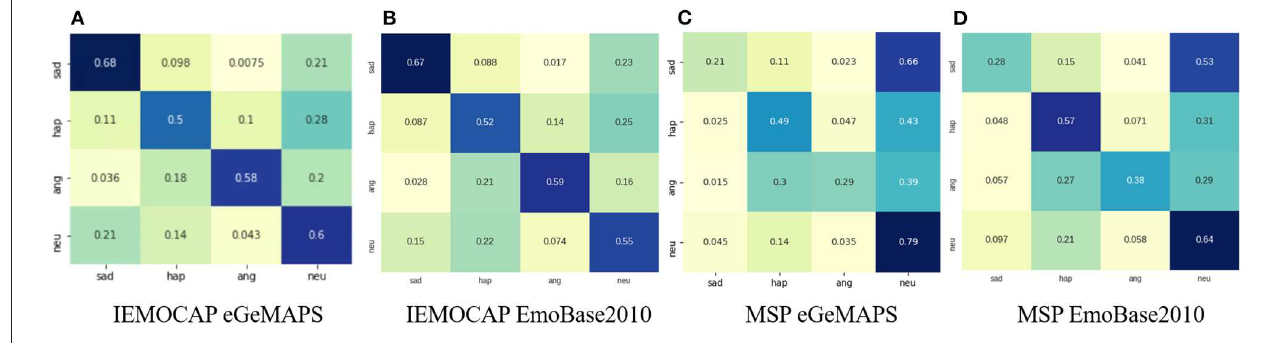
FIGURE 4 | These are the confusion matrices of DCaEN